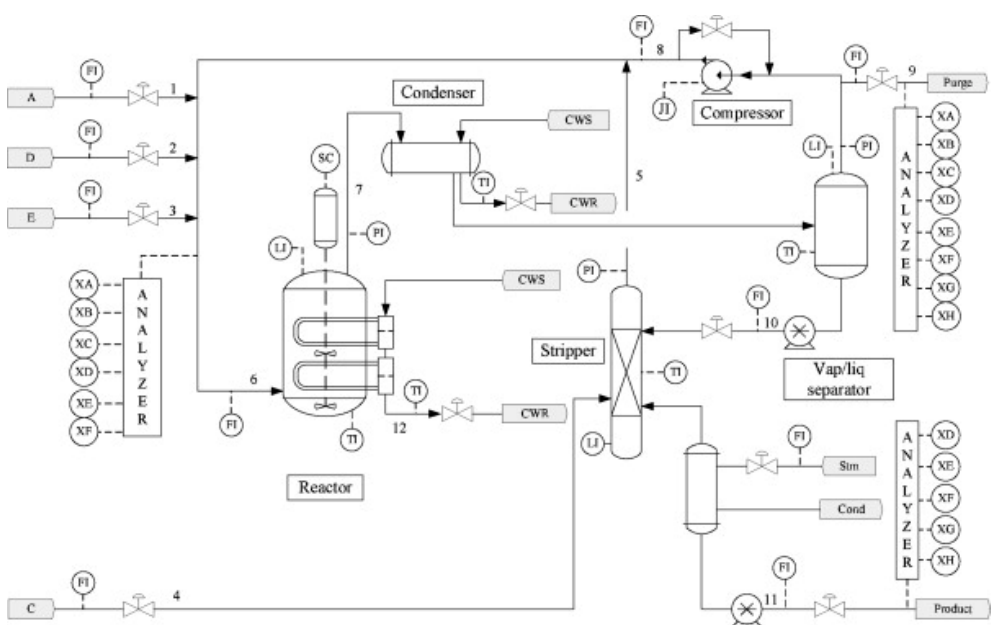
Figure 3. Process flowsheet of TE process. Reprinted with permission from ref. [52] . Copyright 2012 Elsevier.